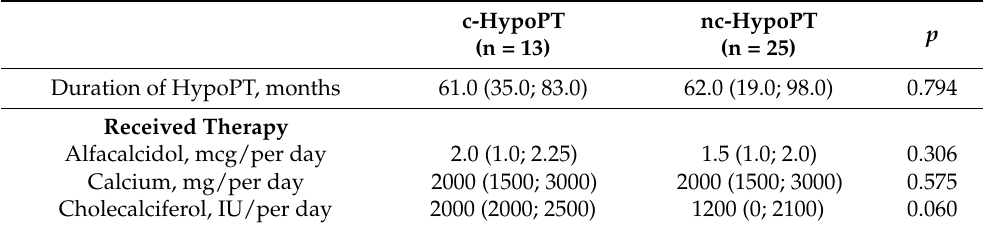
Table 2. Characteristics of the patients with hypoparathyroidism in terms of the underlying disease.